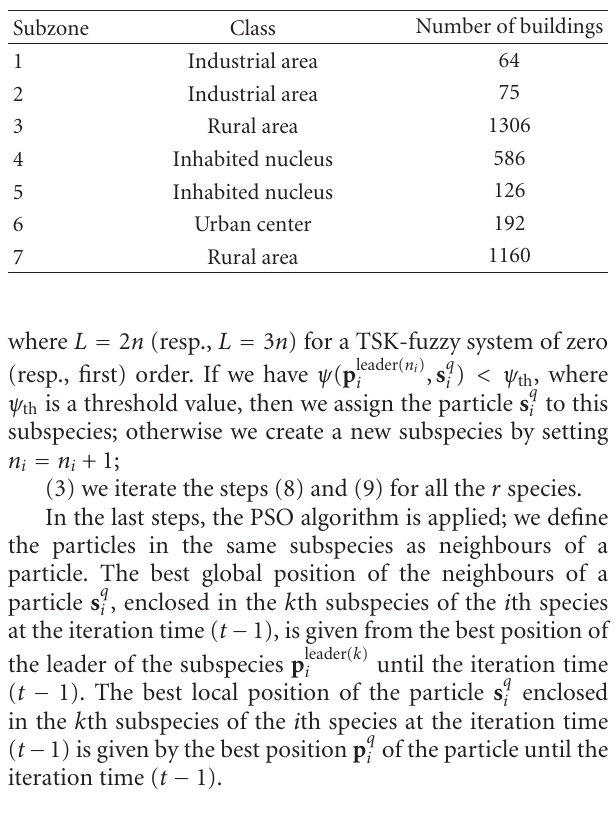
Table 1: Dimension of the pattern subsets included in each